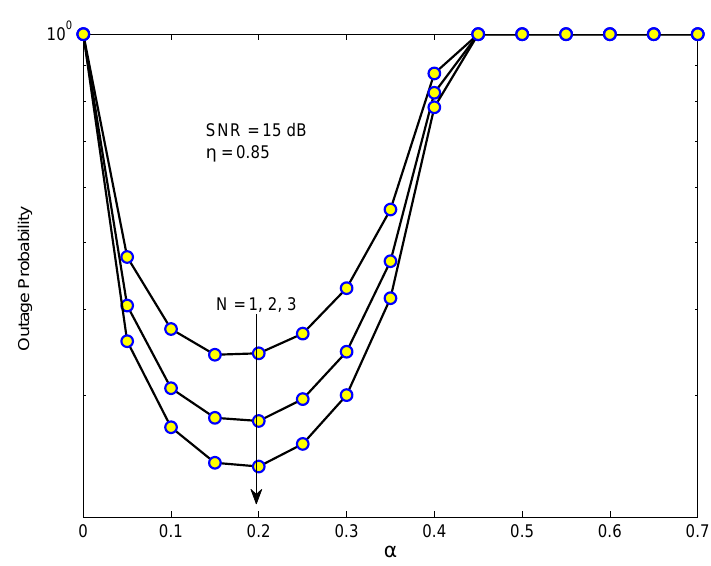
Figure 5. The outage probability of D 1 in EH-NOMA relaying versus the time switching ratio α for different number of relays.